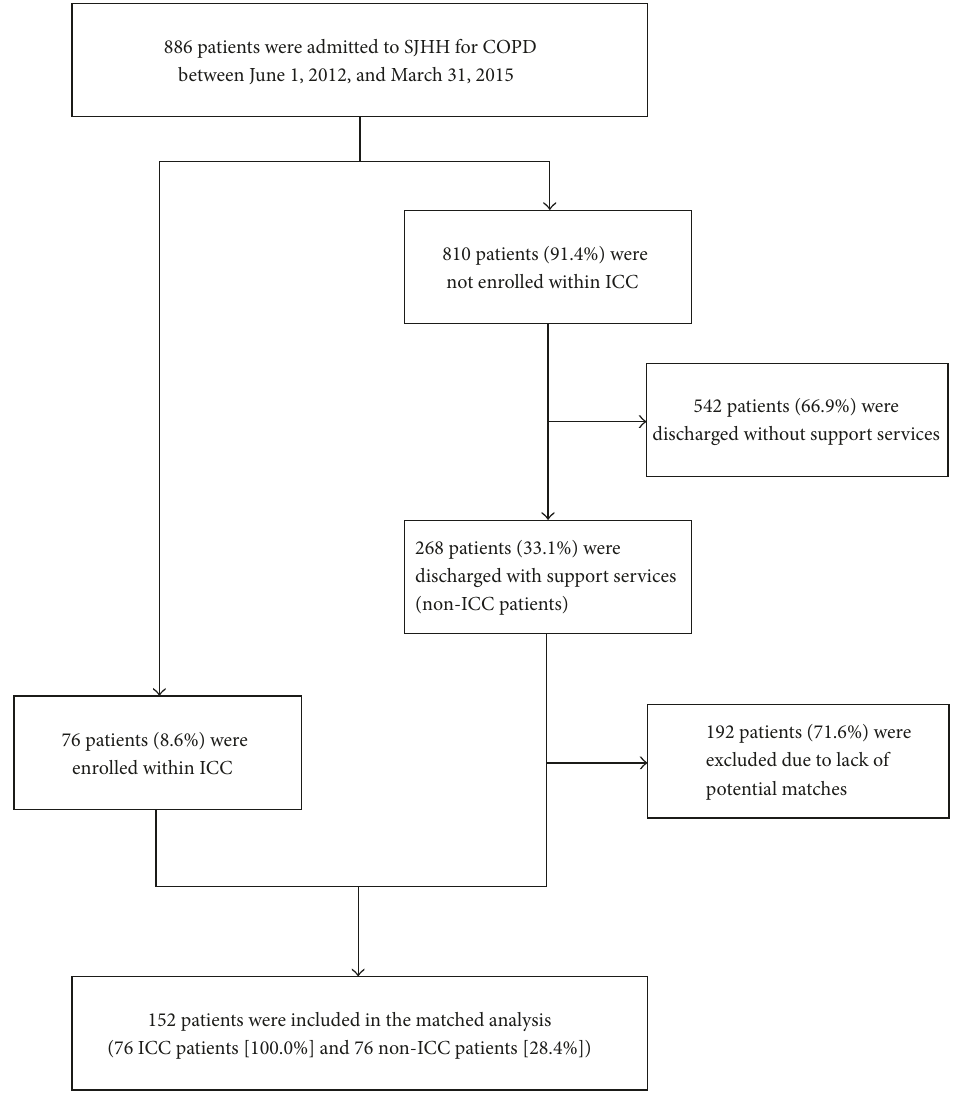
Figure 2: Patient flow-chart of patients admitted for chronic obstructive pulmonary disease at St. Joseph’s Healthcare Hamilton. COPD: chronic obstructive pulmonary disease; ICC: integrated comprehensive care; SJHH: St. Joseph’s Healthcare